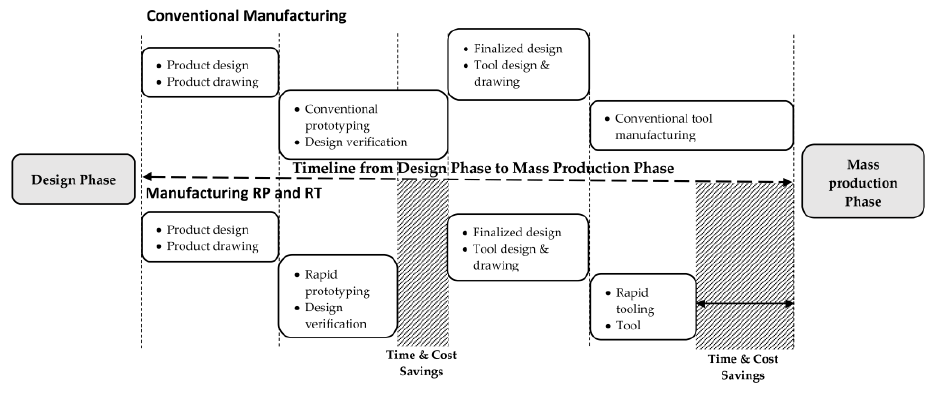
Figure 1. A Review of the Application of Rapid Tooling in Manufacturing [8].